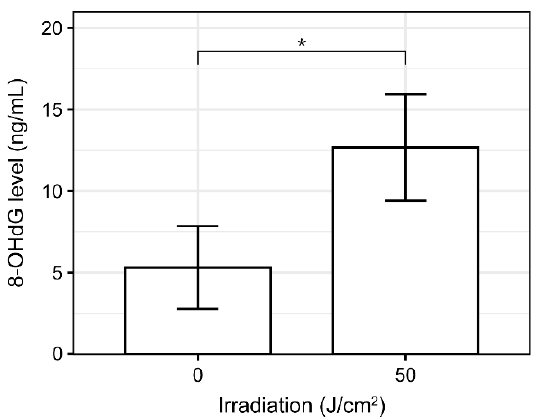
Figure 8. Oxidative stress induced by violet LED irradiation of F. nucleatum subsp. polymorphum ( n = 3) (* p < 0.05, Student’s t -test).